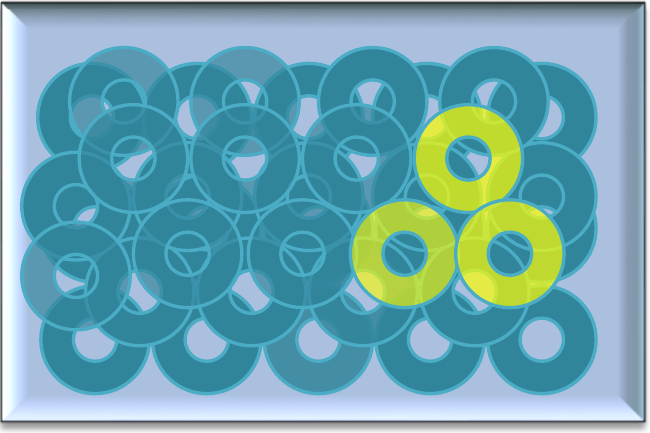
Figure 14. Transmitter with free positioning — matrix coil.